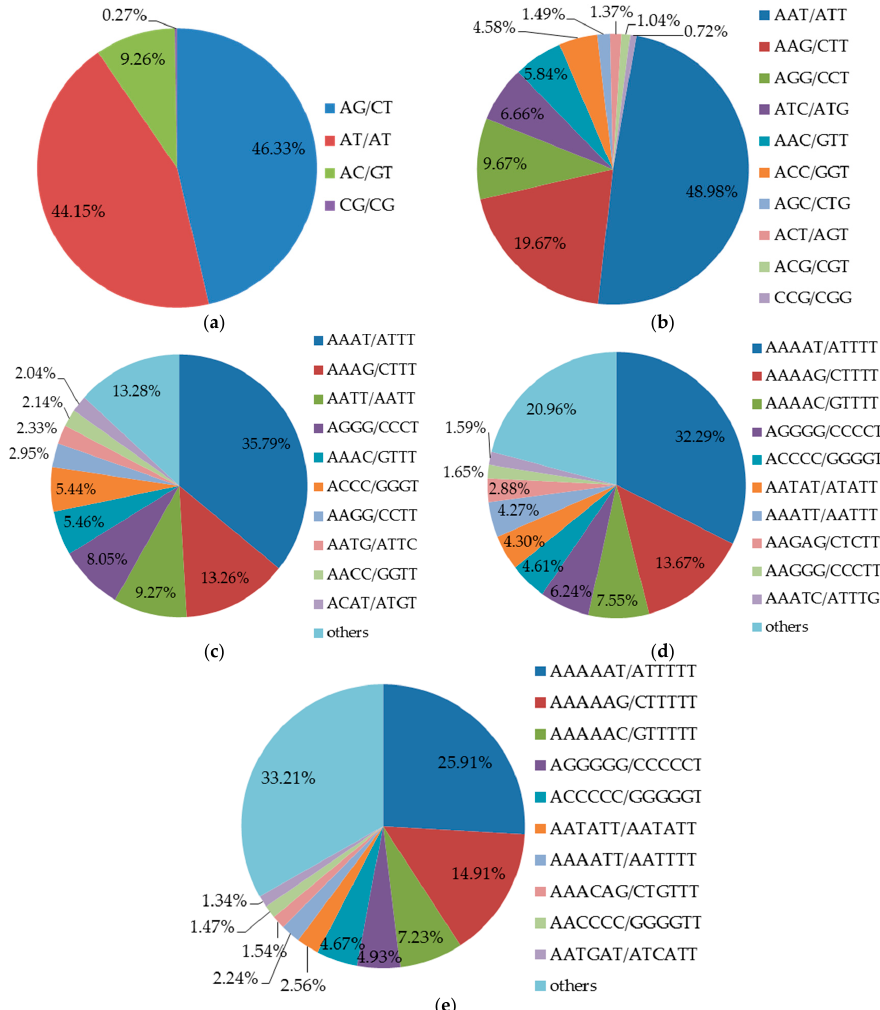
Figure 2. Percentages of different types of repeat motifs in the genome of Betula alnoides . ( a – e ) refer to di ‐ , tri ‐ , tetra ‐ , penta ‐ and hexa ‐ nucleotide repeat motifs, respectively.